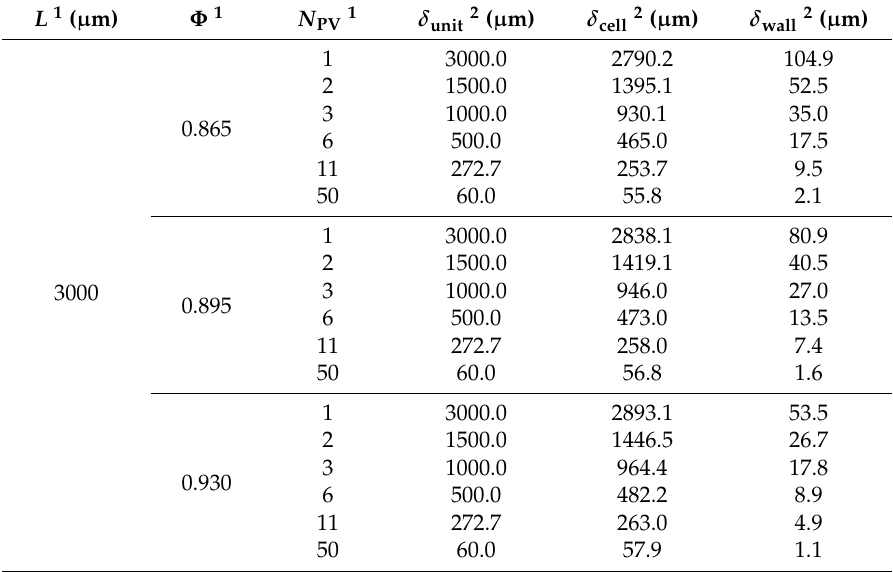
Table 8. Geometric variables for multicellular